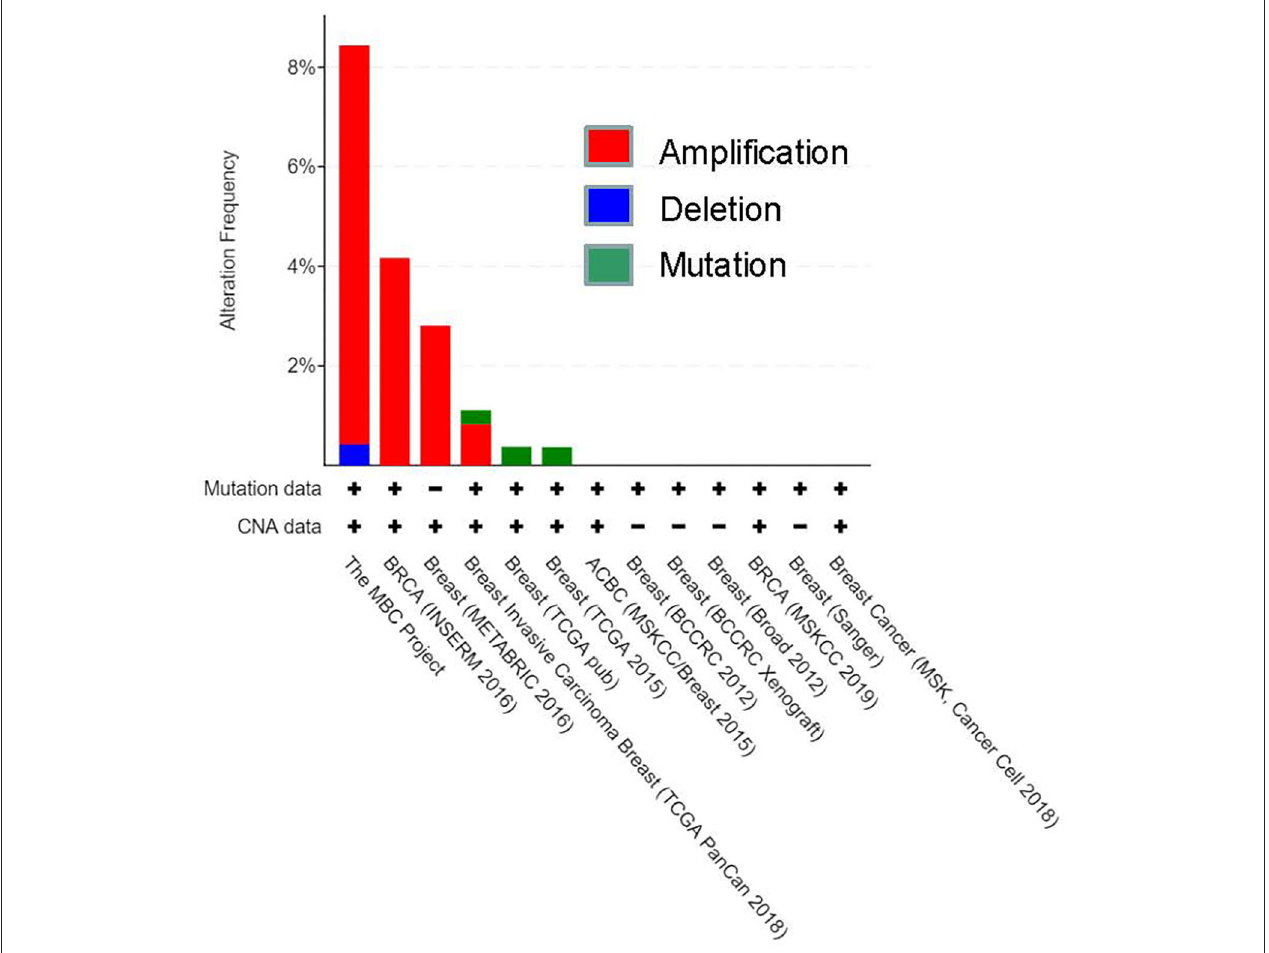
FIGURE 2 | CBioportal analysis of breast cancer database for HOXA5 expression. HOXA5 expression in different types of breast cancer patients using a preexisting cancer gene expression database using a cBioPortal online data analysis tool (https://www.cbioportal.org). The data provided by cBioPortal includes mutations, deletions, and copy-number amplifications for HOXA5; CAN, copy number